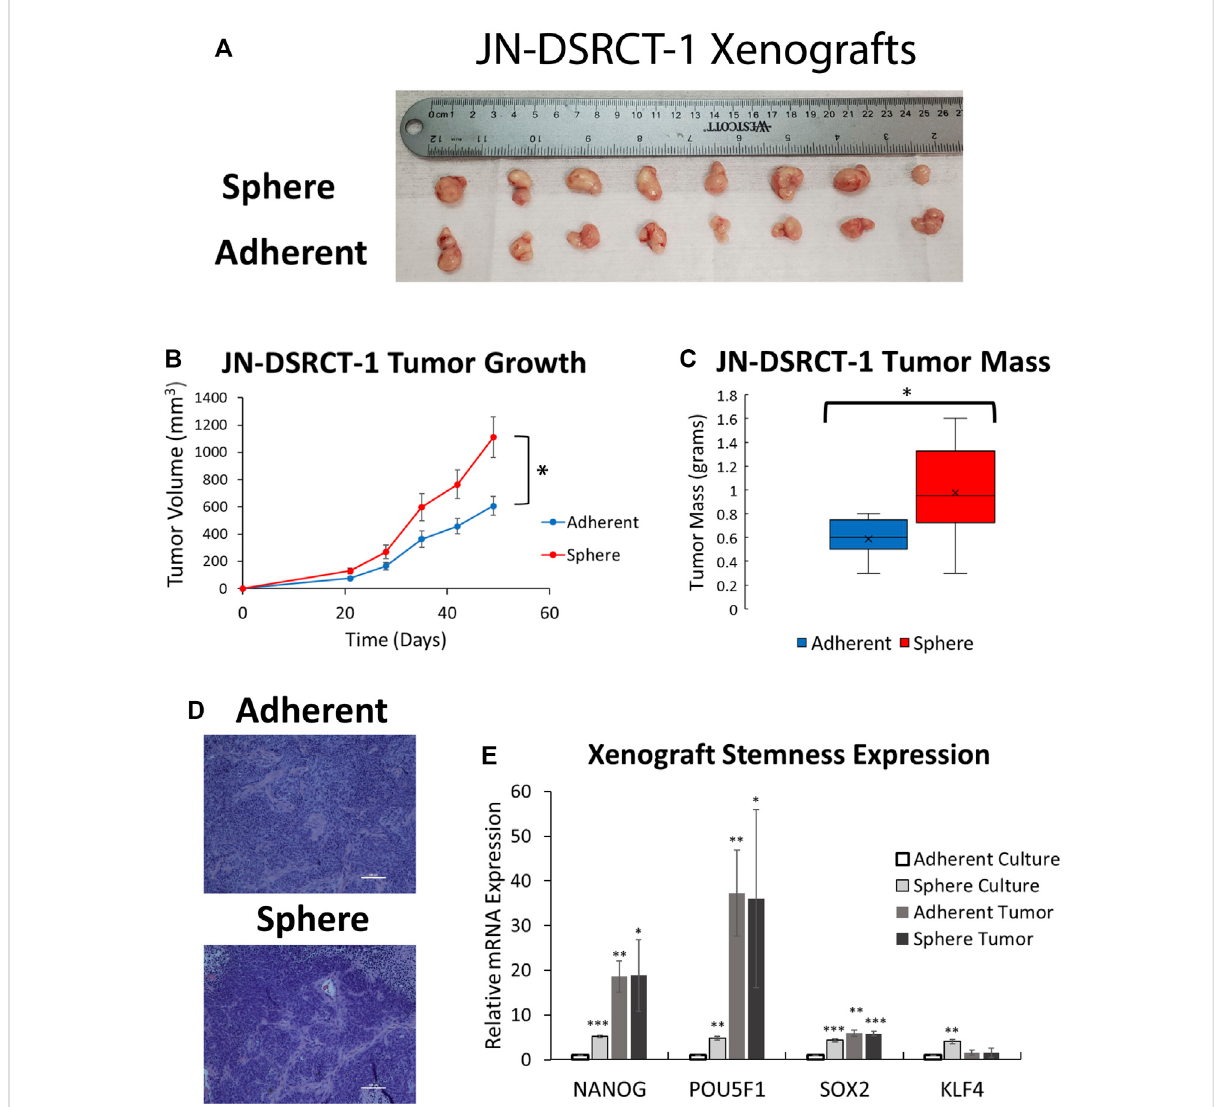
FIGURE 5 DSRCT CSC-like cells form tumors in vivo . (A) JN-DSRCT-1 sphere and adherent culture cells form tumors in 8/8 xenograft injections. (B) Tumor volume of JN-DSRCT-1 xenografts seeded from adherent or sphere culture cells (* p < 0.05, ANOVA). (C) Final mass of JN-DSRCT- 1 xenografts seeded from adherent or sphere culture cells (* p < 0.05, Student ’ s t -test). (D) Representative H&E staining of JN-DSRCT-1 xenografts seeded from adherent or sphere culture cells. (E) Relative mRNA expression of NANOG, POU5F1, SOX2, and KLF4 in JN-DSRCT-1 cells in adherentculture,sphereculture,xenograft tumorsderivedfromadherentculture,orxenograft tumorsderivedfromspherecultureassessed via RT- qPCR ( n = 3, * p < 0.05, ** p < 0.01, *** p < 0.001, Student ’ s t -test).